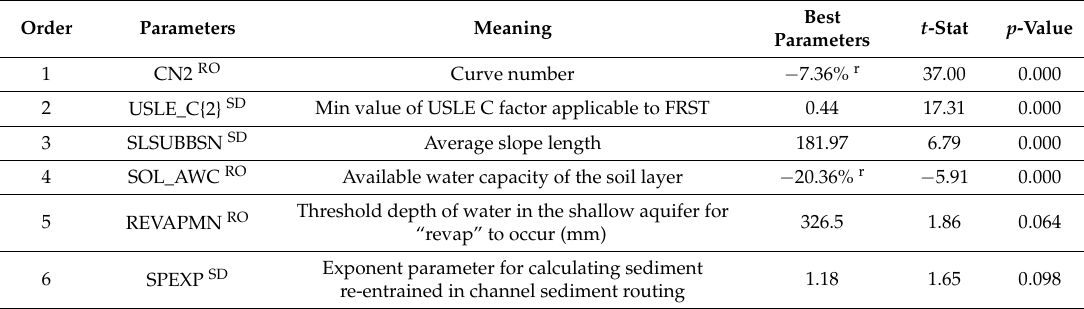
Table 3. List of sensitive parameters calibrated based on global sensitivity